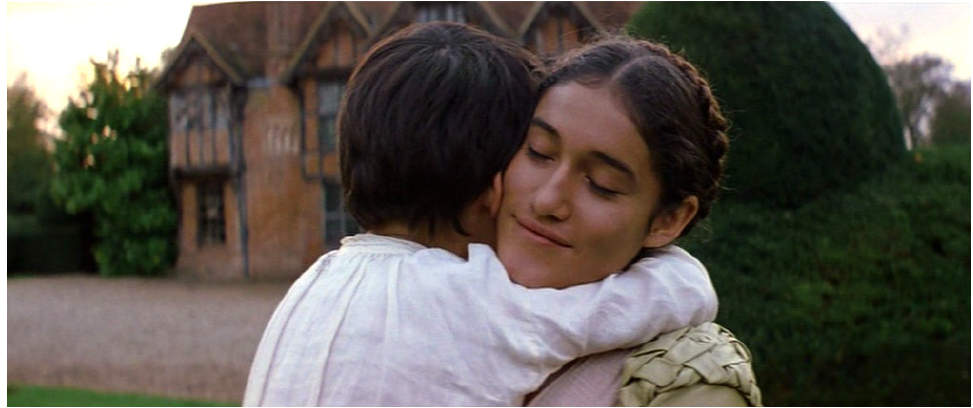
Figure 9: Pocahontas’ love for her son is seen in an over-the-shoulder reaction shot echoing her encounter in Figure